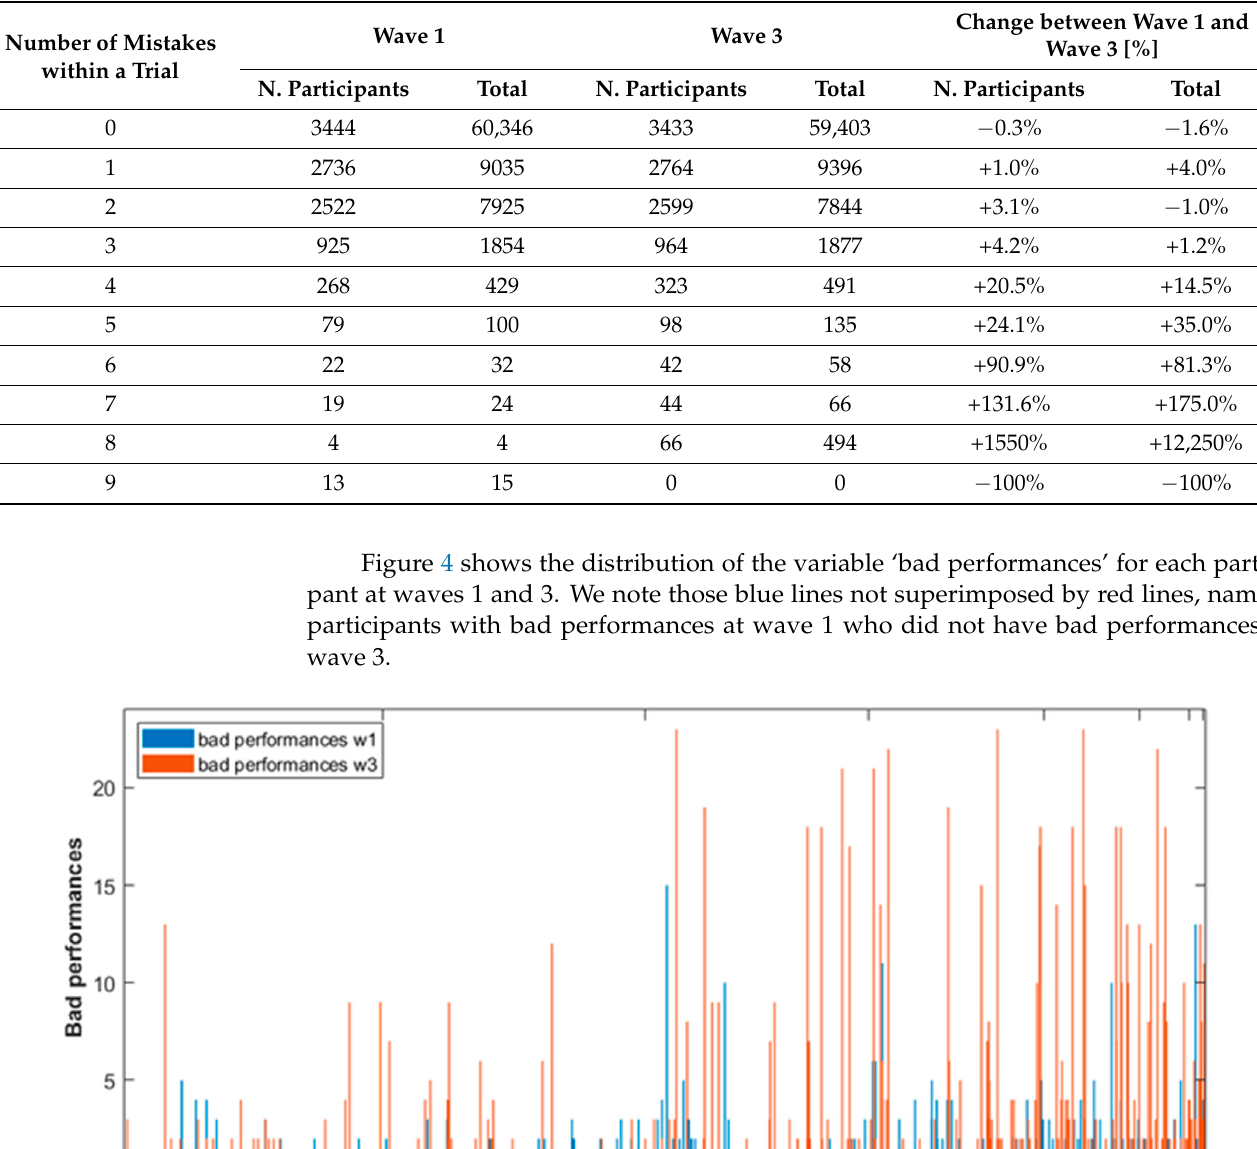
Table 2. Summary of distribution density for the individual trial mistakes at wave 1 and wave 3.